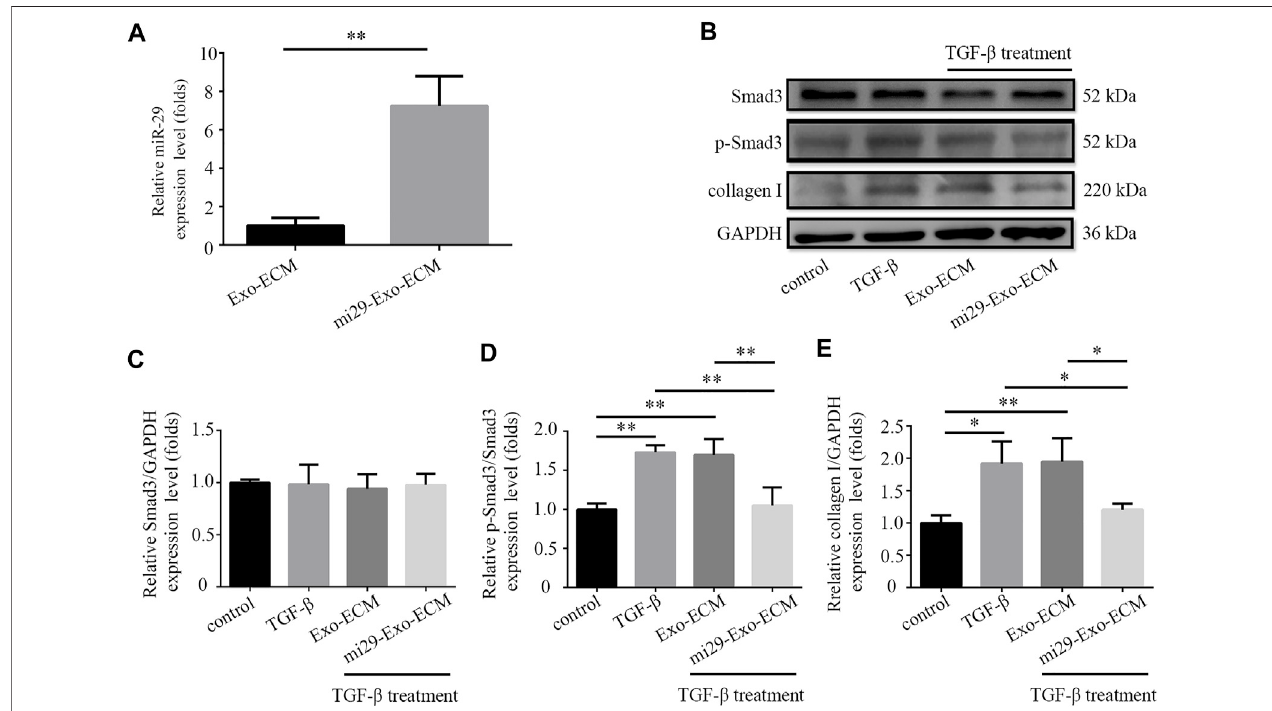
FIGURE5| Mi29-Exo-ECMinhibitedTGF- β -induced accumulationofcollagenIinNIH3T3cells. (A) ExpressionlevelofmiR-29 inmi29-Exo-ECMwasdetermined by qRT-PCR. “ Exo-ECM ” : exosomes from ECM of HFF-CBD-Lamp2b cells; “ mi29-Exo-ECM ” : exosomes from mi29-Exo-ECM. Data are represented as mean ± SD ( n (cid:1) 3). Student ’ s t-test was performed; “ ** ” : p < 0.01. (B) The changes of collagen I protein levels and phosphorylation levels of Smad3 were analyzed by Western blot. RelativeexpressionlevelsofSmad3 (C) , p -Smad3/Smad3 (D) ,collagenI (E) werequanti fi ed.TheGAPDHwasusedasaninternalcontrol. “ Control ” :NIH3T3cells; “ TGF- β ” : TGF- β -induced NIH 3T3 cells; “ Exo-ECM ” : Exo-ECM treatment; “ mi29-Exo-ECM ” : mi29-Exo-ECM treatment; Data are represented as mean ± SD ( n (cid:1) 3). ANOVA was performed; “ * ” : p < 0.05; “ ** ” : p < 0.01.